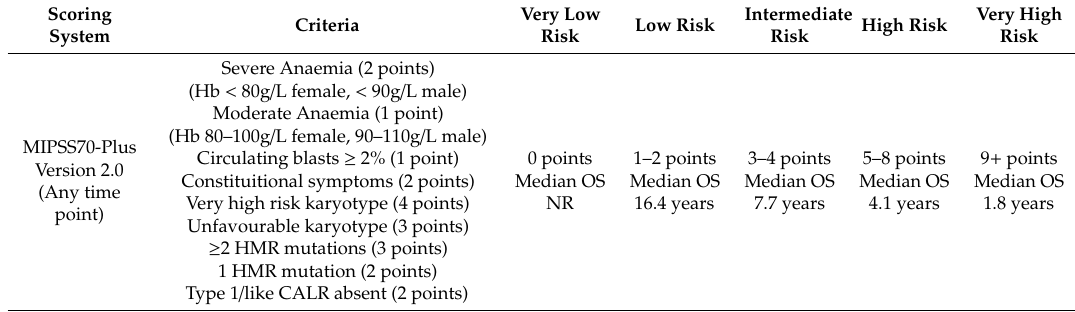
Table 2. Mutation enhanced international prognostic scoring system (MIPSS70-Plus) adapted from [12] which can be applied at any time point of the disease: very high risk karyotypes include − 7, inv(3) / 3q21, i(17q), 12p- / 12p11.2, 11q- / 11q23 or autosomal trisomies other than + 8 or + 9; unfavourable karyotypes include any karyotype other than normal or sole abnormalities of 20q-, 13q-, + 9, chromosome 1 translocation / duplication, -Y or sex chromosome abnormality; HMR, high molecular risk mutations include ASXL1, SRSF2, EZH2, IDH1, IDH2 and U2AF1Q157 ; NR, not reached; Int, intermediate.